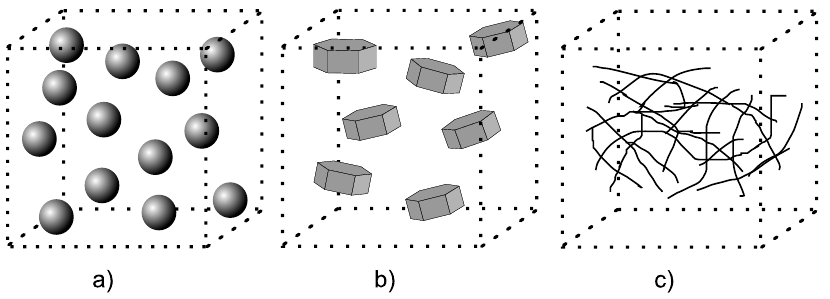
Figure 2. Different fillers used in matrices ( a ) dispersed particles; ( b ) exfoliated layered nanosilicates; ( c ) nonwoven